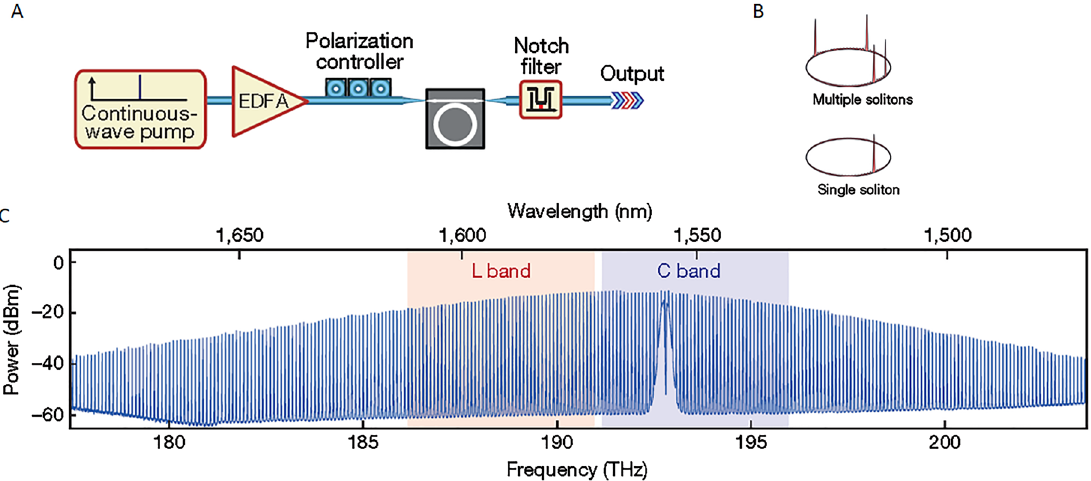
Figure 8: Bright DKS-based micro-comb generation in high- Q silicon nitride microresonators. (A) Schematic setup of the bright DKS micro-comb generation. (B) Illustration of single soliton and multiple solitons. (C) Optical spectrumof a single-soliton frequencycombafter the suppression of residual pumplight. Reprinted (adapted)with the permissionfrom Ref. [91],Copyright 2017, Springer Nature.